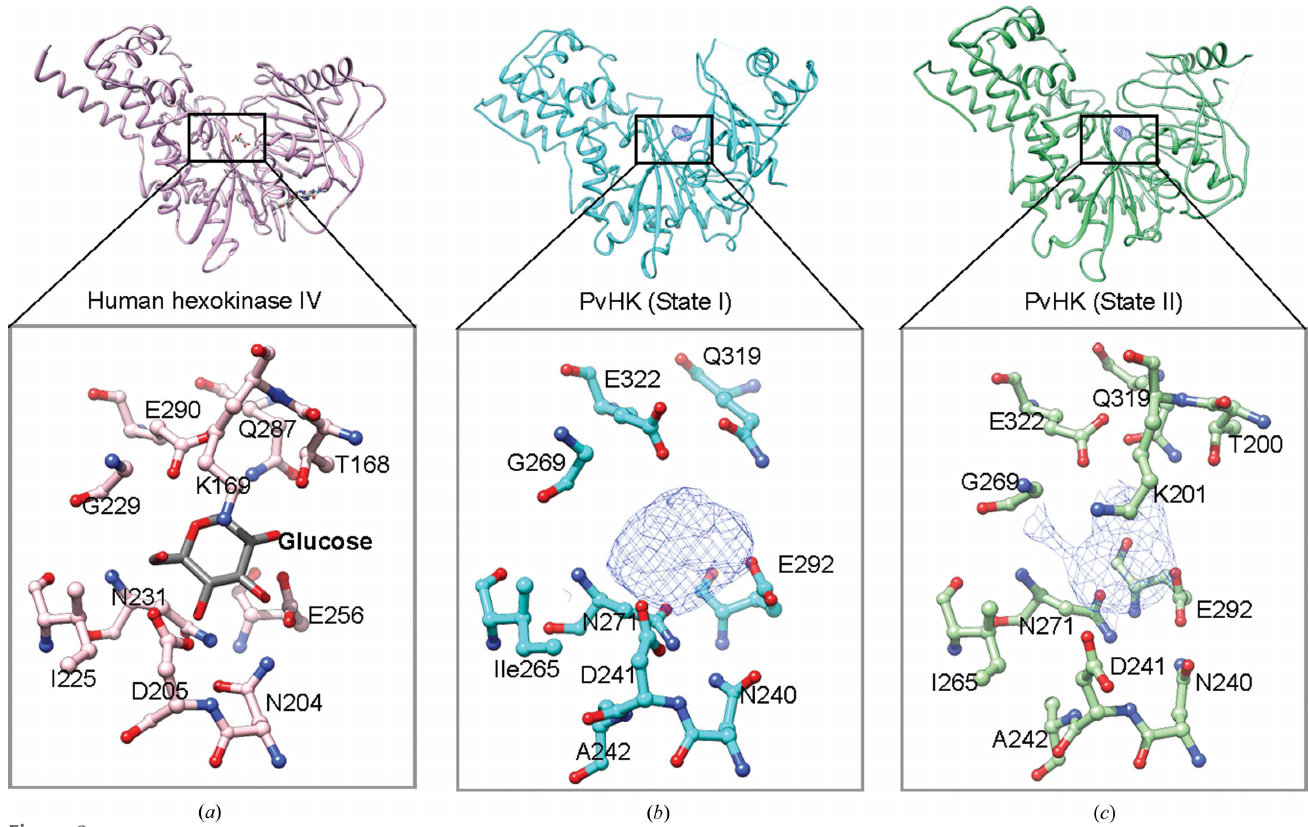
Figure 2 Comparison of the active sites of human hexokinase IV and PvHK. ( a ) Crystal structure of human hexokinase IV (glucokinase) in the active closed conformation with BGC (glucose) and activator. The glucose-binding site is highlighted in the close-up view and the glucose-coordinating residues are shown (PDB entry 4dhy). ( b ) Cryo-EM-derived PvHK protomer in the open state. The unmodeled ligand density (mesh) at the hexose-binding site is shown along with the residues that appear to coordinate the ligand. ( c ) The PvHK protomer in the closed conformation with extra density present in the active site. In the close-up view, the extra density and coordinating residues are shown for a one-to-one comparison with human hexokinase. Most of the residues in human hexokinase and PvHK are conserved and are seen in a very similar conformation in PvHK to that observed in human